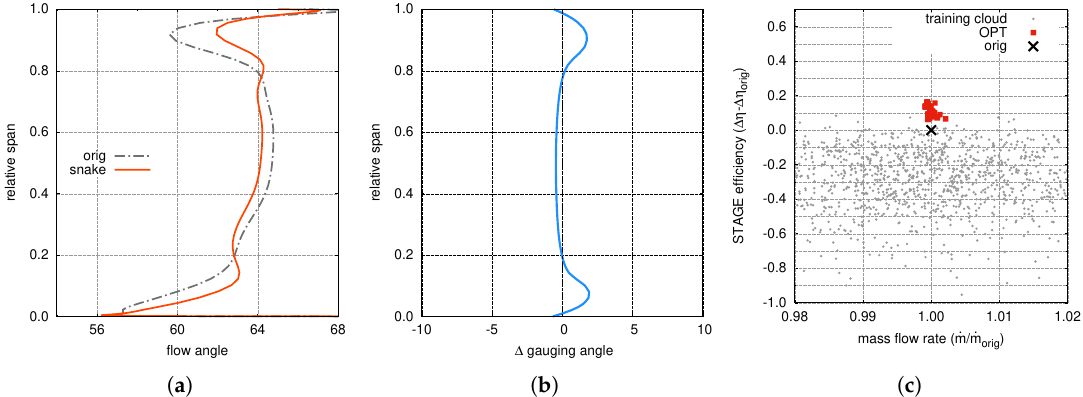
Figure 12. Results of the design campaign with cavity purge flows included: ( a ) swirl angle distribution at stator exit; ( b ) morphing parameter distribution along the span; ( c ) optimization clouds.